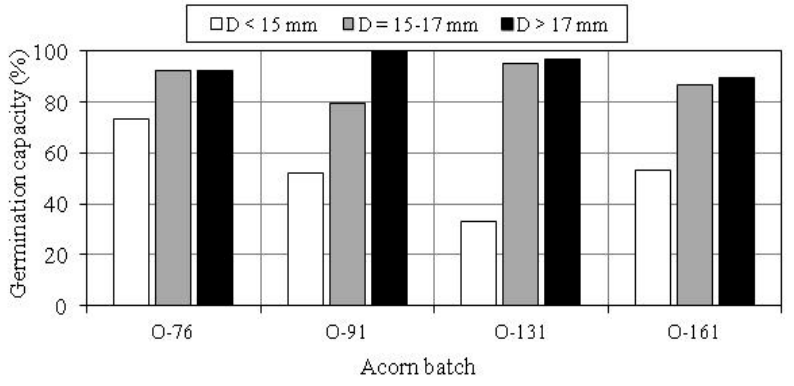
Figure 6. Germination capacity of pedunculate oak acorns divided into three size groups.